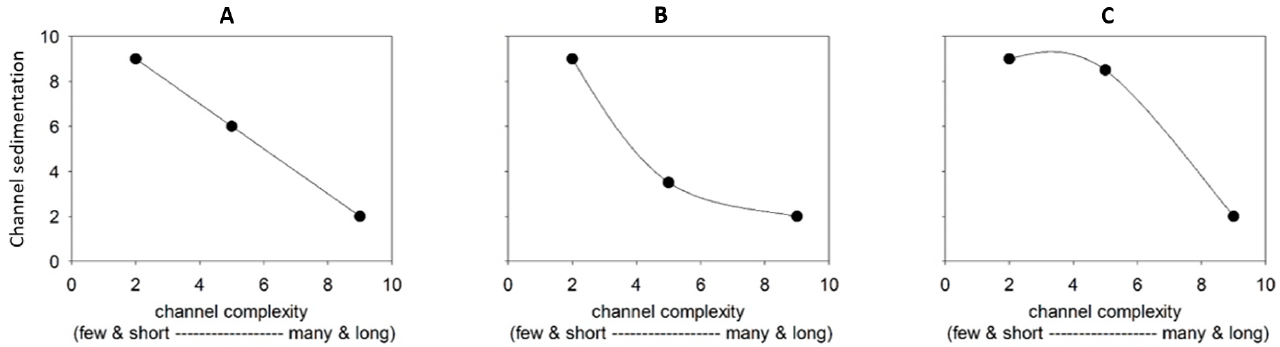
Figure 3. Possible relationships between the channel complexity and sedimentation. In ( A ), river managers can be confident that a given change in delta complexity always will require a similar change in navigation dredging. In ( B ), river managers could expect little change in navigation dredging as channel complexity changed from 7 to 10 (delta building), or vice versa (delta degradation), but could expect large changes in navigation dredging as channel complexity changed from 2 to 5 (delta building), or vice versa (delta degradation). Likewise for ( C ) but in that situation, sedimentation is less sensitive to channel complexity in simple deltas but is more sensitive to channel complexity in complex deltas.